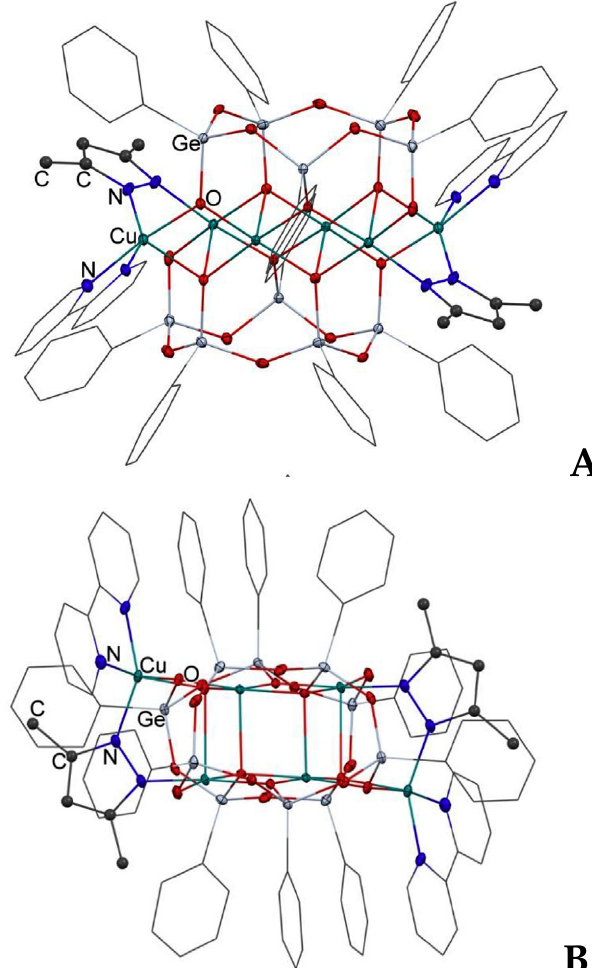
Figure 16. Molecular structure of complex 21 . ( A ): side view. ( B ): top. View. Color code: Ge: grey, O: red, Cu: green, N: blue. Adapted from [89], Copyright (2019) with permission of Elsevier.